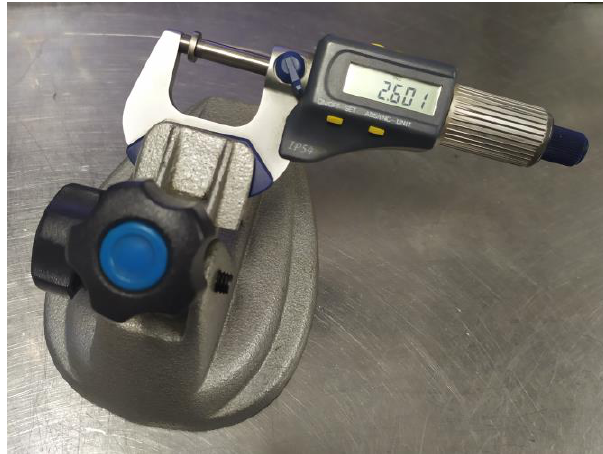
Fig. 9. Measurement of the adjusting shim thickness after grinding